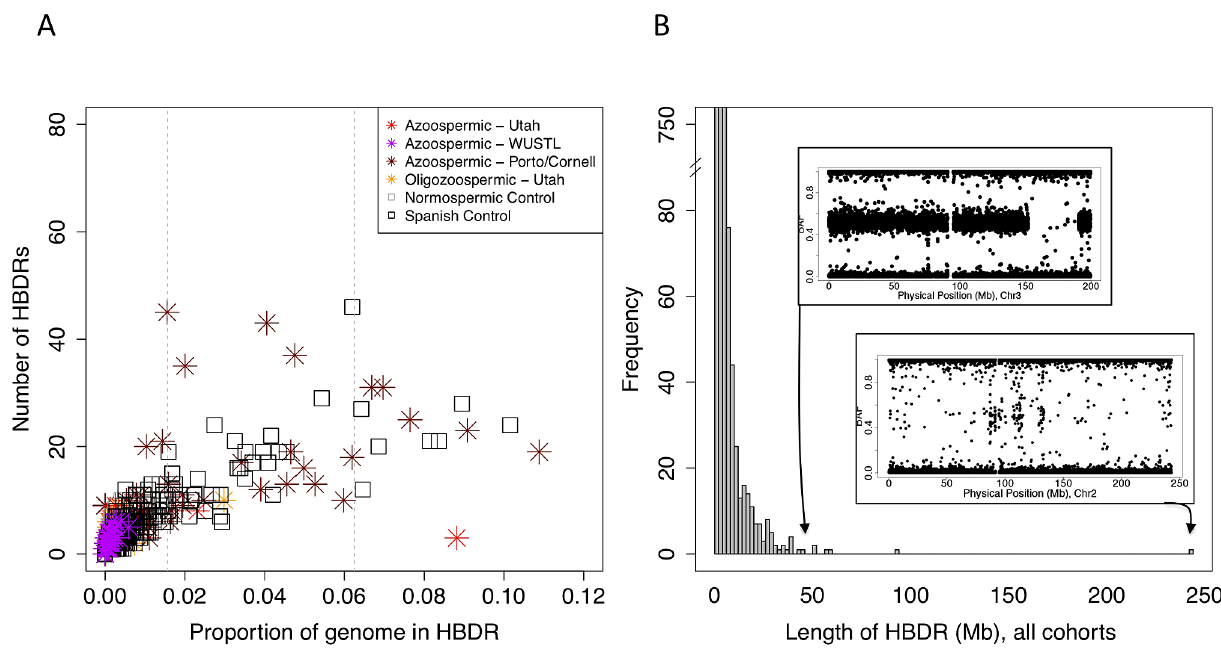
Figure 4. Patterns of homozygosity in men with low sperm count. (A) Distribution of the number of HBD regions (HBDRs), and the proportion of genome contained in these putative HBD regions, plotted for each sample in this study. Replication case and control cohorts are indicated in the legend. (B) Length distribution of HBDRs detected in all samples combined. Inset, two panels showing probe level intensity data corresponding to the two largest HBDRs detected. BAF: b-allele frequency, calculated as B/(A + B) where A and B are the approximate copy numbers for the A and B allele, respectively. The largest HBDR detected corresponds to a case of uniparental disomy of chromosome 2 (UPD2) detected in an azoospermic man from the Utah cohort.